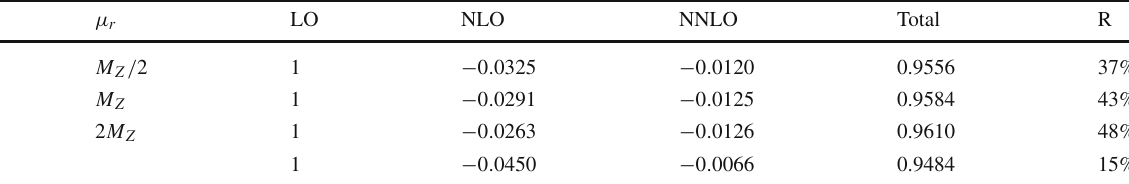
Table 2 The QCD correction factors A FB / A LO forward–backward asymmetry with the quark axis definition at LO, NLO, NNLO using the conventional (Conv.) and PMC scale settings.